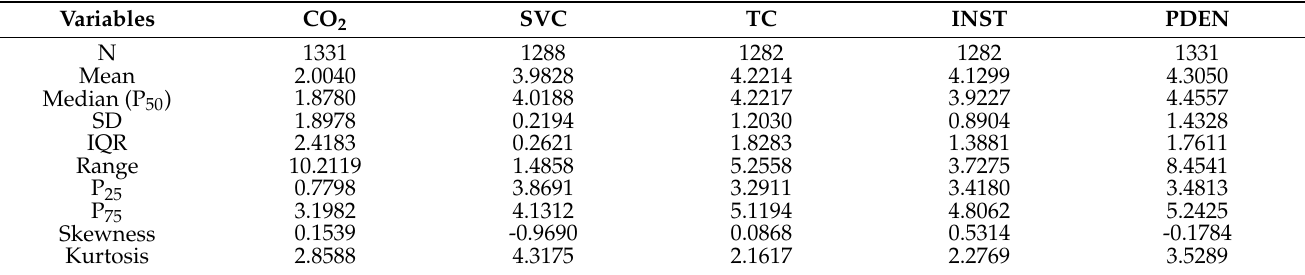
Table 2. Descriptive indicators/Statistics of the Study Variables.